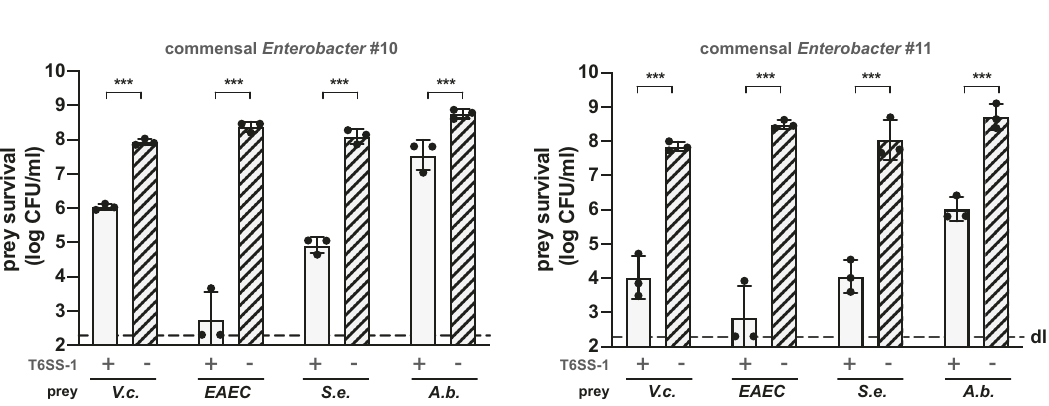
Fig. 3 E. cloacae complex isolates kill pathogenic bacteria in a T6SS-1-dependent manner. Toxigenic V. cholerae ( V.c .; T6SS-de fi cient), enteroaggregative E. coli ( EAEC ), S. enterica serovar Typhimurium ( S.e .), or A. baumannii ( A.b .; T6SS-de fi cient) were co-incubated with commensal Enterobacter isolates #10 and #11 and their survival was scored as indicated on the Y- axis. Values are derived from three independent experiments and the bars represent the mean (±SD, as de fi ned by the error bars). Signi fi cant differences were determined using a two-sided Student ’ s t -test corrected for multiple comparisons. *** p < 0.001. Underlying source data are provided in the Source data fi